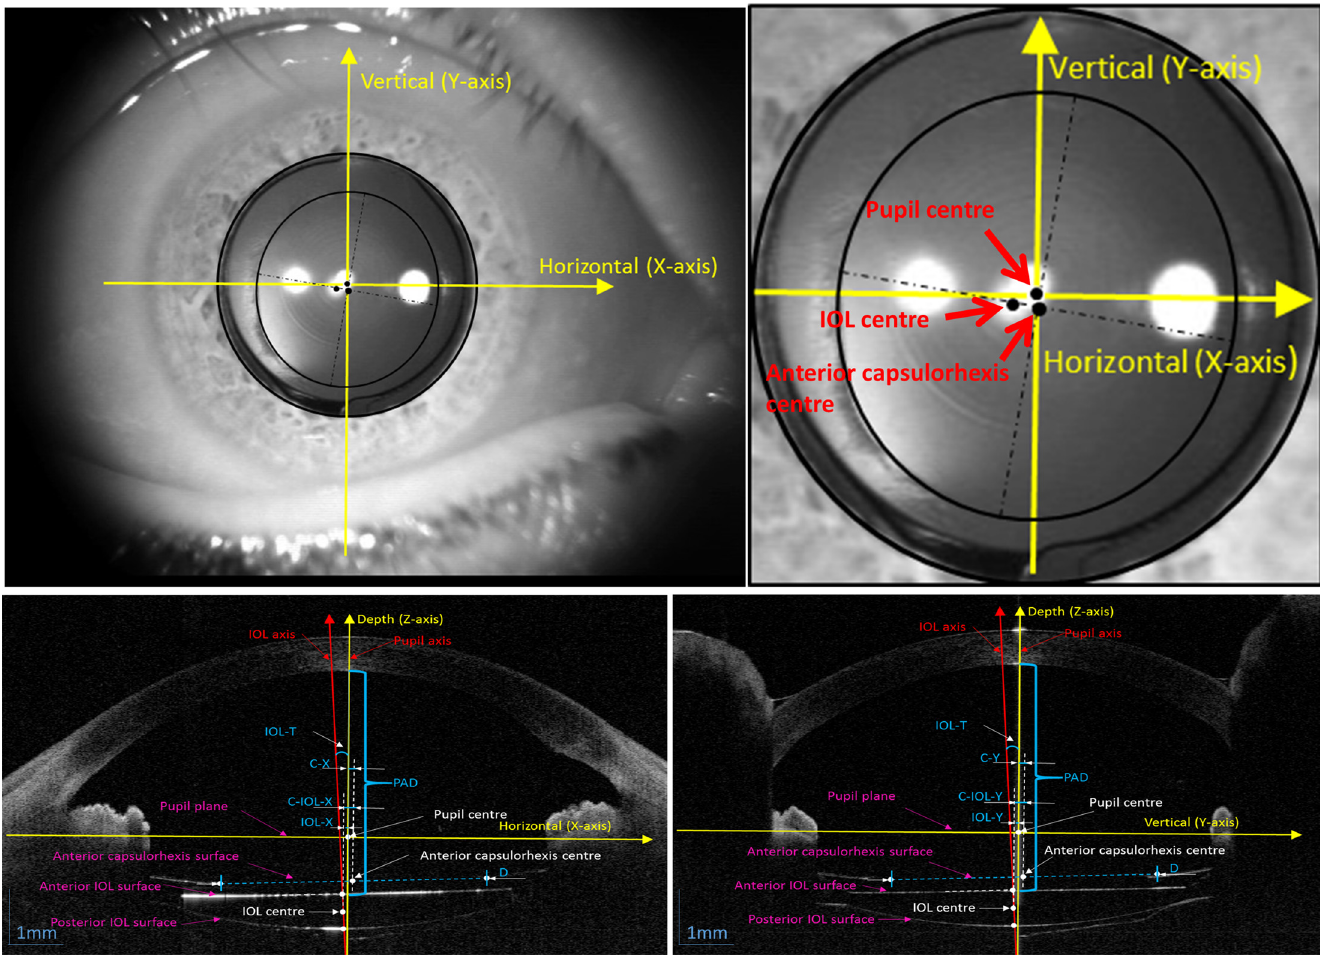
Fig 3. Definition for all parameters in different cross-sectional views. PAD = Postoperative aqueous depth; IOL = intraocular lens; IOL-T = intraocular lens tilt; D = Anterior capsulorhexis diameter; IOL-X = IOL decentration in the x-axis; IOL-Y = IOL decentration in the y-axis; C-X = Anterior capsulorhexis decentration in the x-axis; C-Y = Anterior capsulorhexis decentration in the y-axis; C-IOL-X = Anterior capsulorhexis-IOL decentration in the x-axis; C-IOL-Y = Anterior capsulorhexis-IOL decentration in the